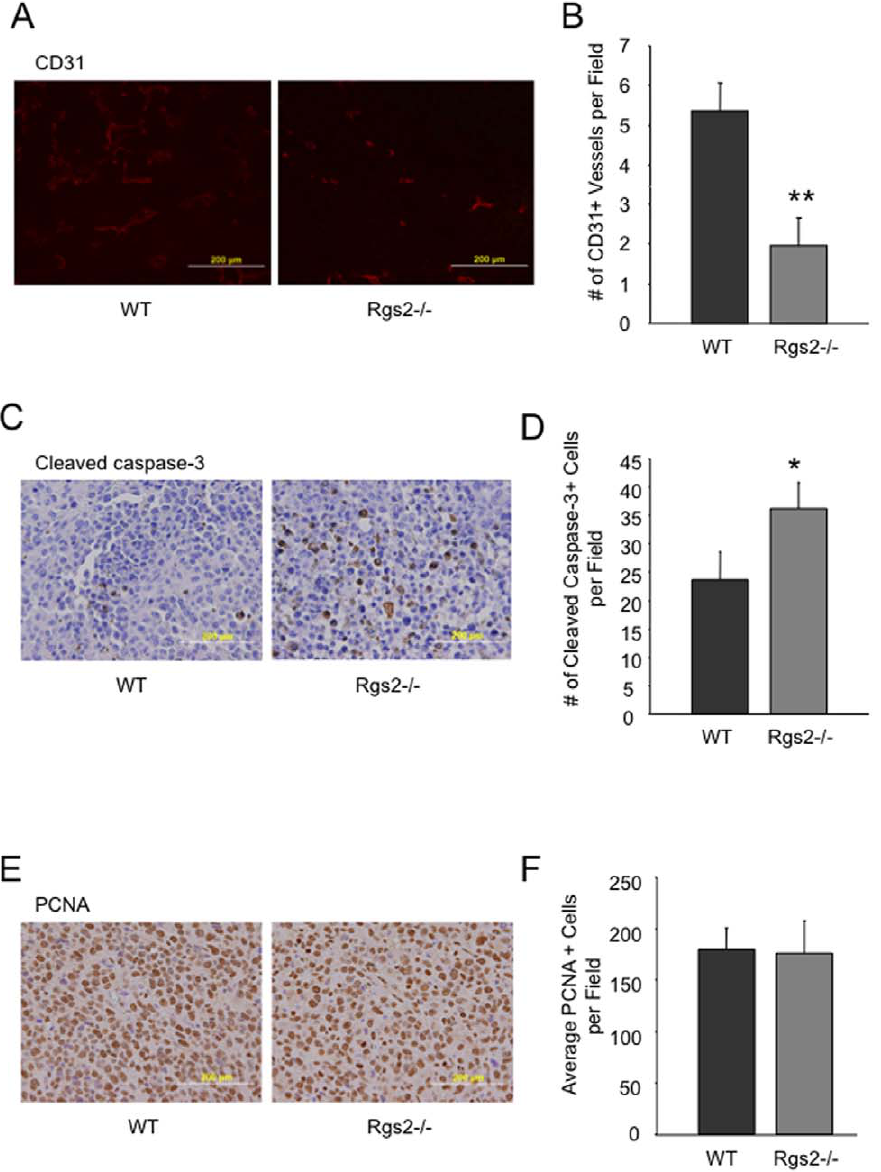
Figure 5. Tumors in Rgs2 2 / 2 mice exhibit decreased vascular density and increased cell death. (A), (C), (E) Sections from size matched 3LL tumors grown in wild type mice and Rgs2 null mice were stained for CD31, active caspase-3 and PCNA, respectively. Representative images are shown. (B), (D), (F) The numbers of CD31 positive vascular structures, active caspase-3 positive cells, and PCNA positive cells, respectively, were quantified in 10 randomly selected fields under microscopy. These experiments were repeated 3–4 times. ** p , 0.005, * p , 0.05.